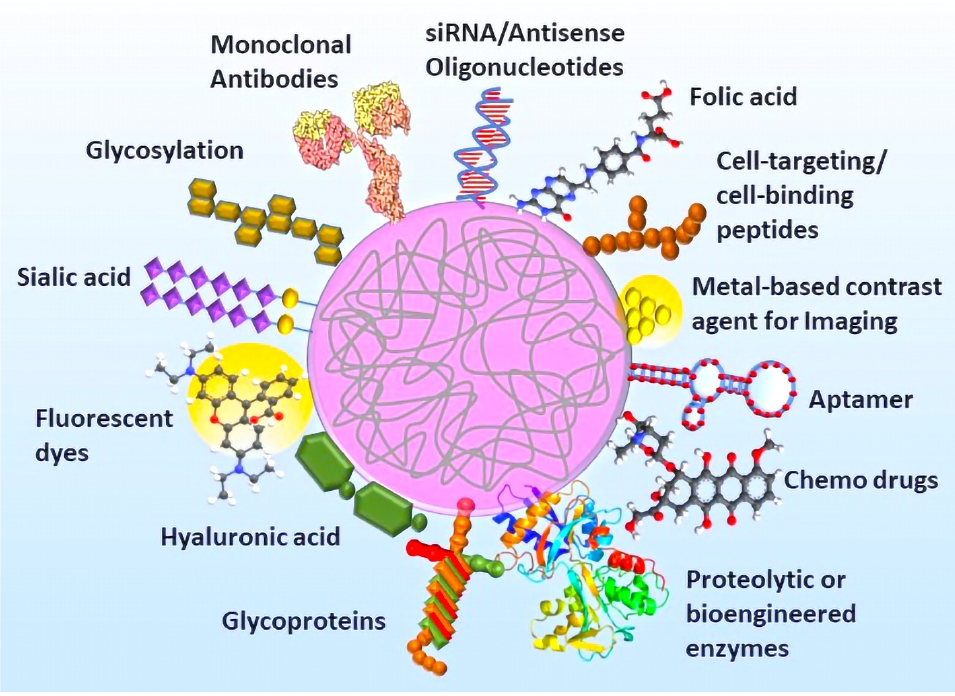
Figure 2. Surface modifications of NGs with various chemical/biological moieties for biomedical